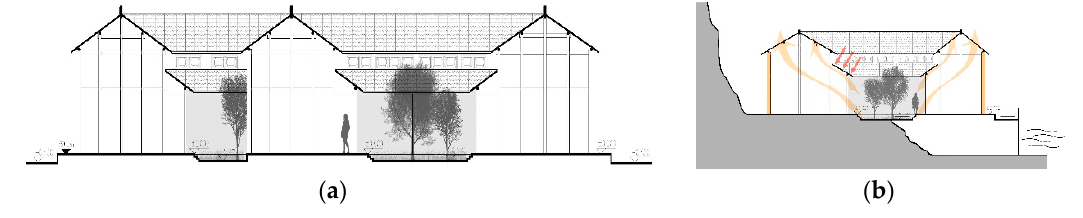
Figure 7. Building sections in ( a ) Heyang and ( b ) Danzhi.